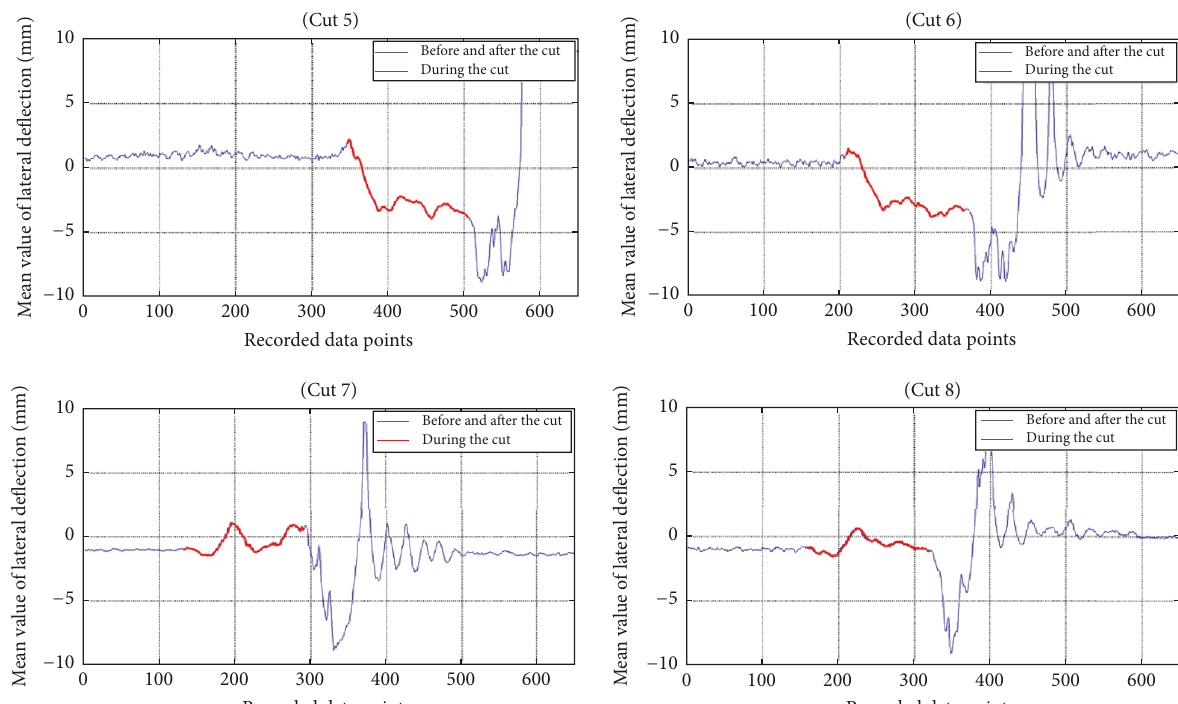
Figure 19: Experimental cutting results, cut at 2800